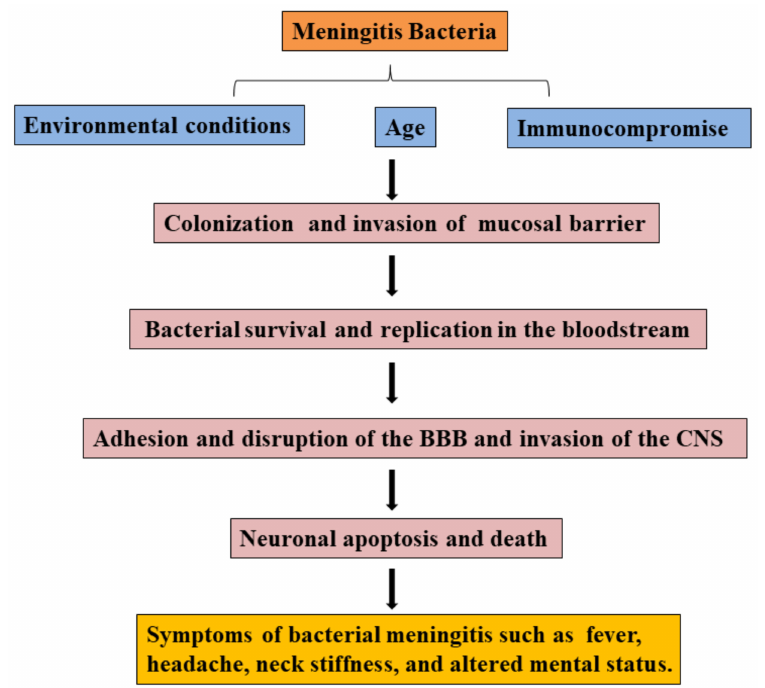
Figure 1. Overview of the pathogenic process in bacterial